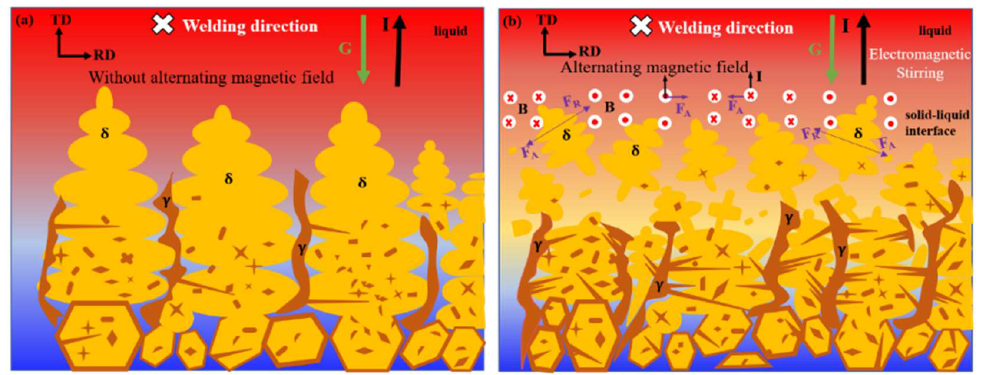
Figure 10. Effect of an alternating magnetic field on the dendrite arrangement during solidification. ( a ) Without alternating magnetic field; ( b ) Alternating magnetic field.